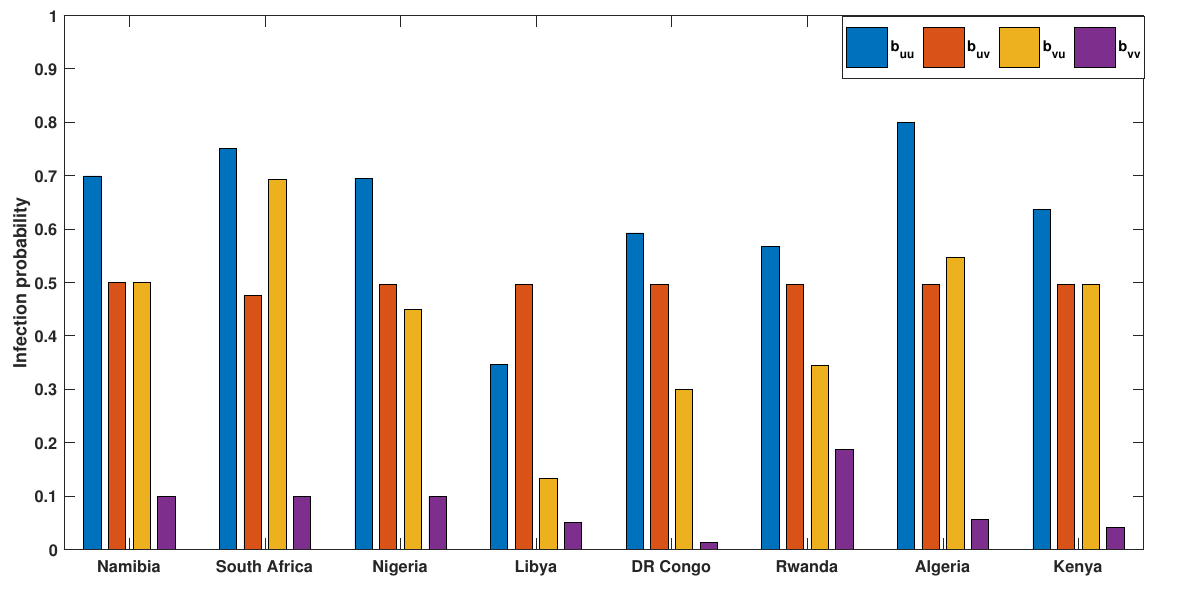
Figure A3. Bar plot presenting the estimated infection probabilities for vaccinated and unvaccinated individuals for selected African countries.